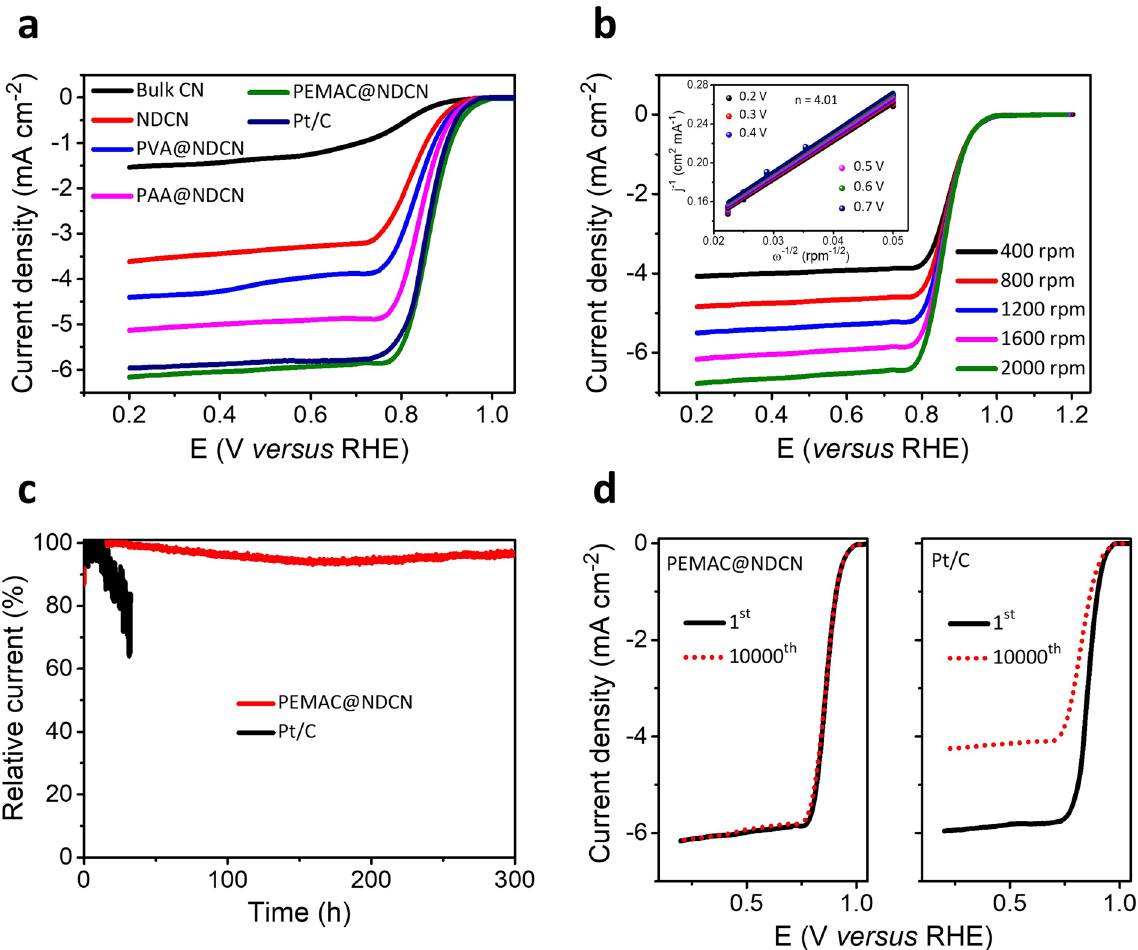
Fig. 5 Electrochemical ORR performances for polymer‑incorporated metal‑free catalysts. a LSV profiles for the PEMAC@NDCN compared to those of commercial Pt/C, and other PVA@NDCN, PAA@NDCN, NDCN, bulk CN catalysts. b RDE polarizations of PEMAC@NDCN over 400–2000 rpm sweeping rates. Inset displays the characteristics K‑L plots for electrochemical kinetics in the range of 0.2–0.7 V potentials of